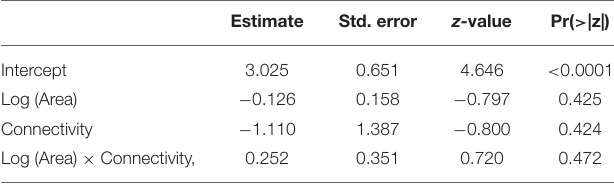
TABLE 3 | Parameter estimates and P- values for the GLM (Poisson distribution, log link function) built for species density as a function of Log (Area), Connectivity and the interaction Log (Area) x Connectivity.